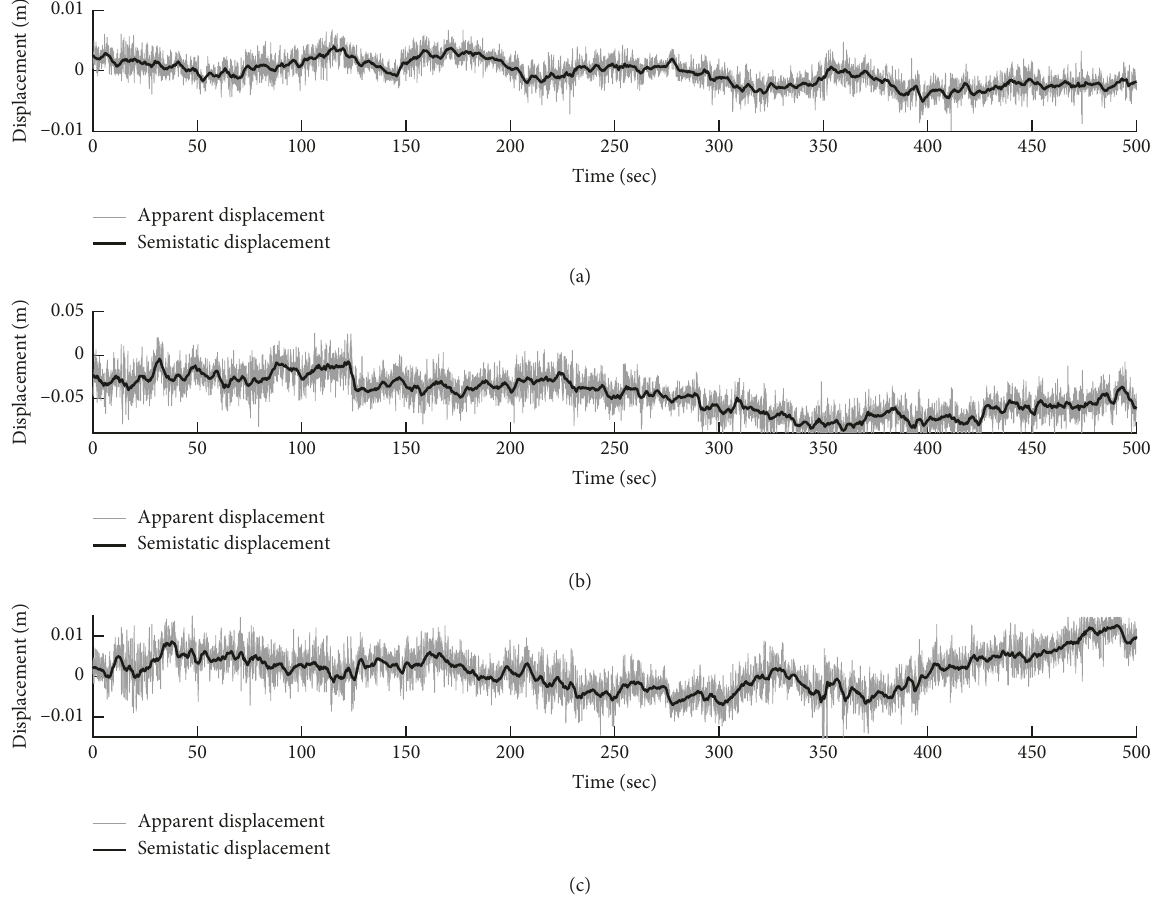
Figure 9: Semistatic displacements in three directions: (a) N-S, (b) E-W, and (c)